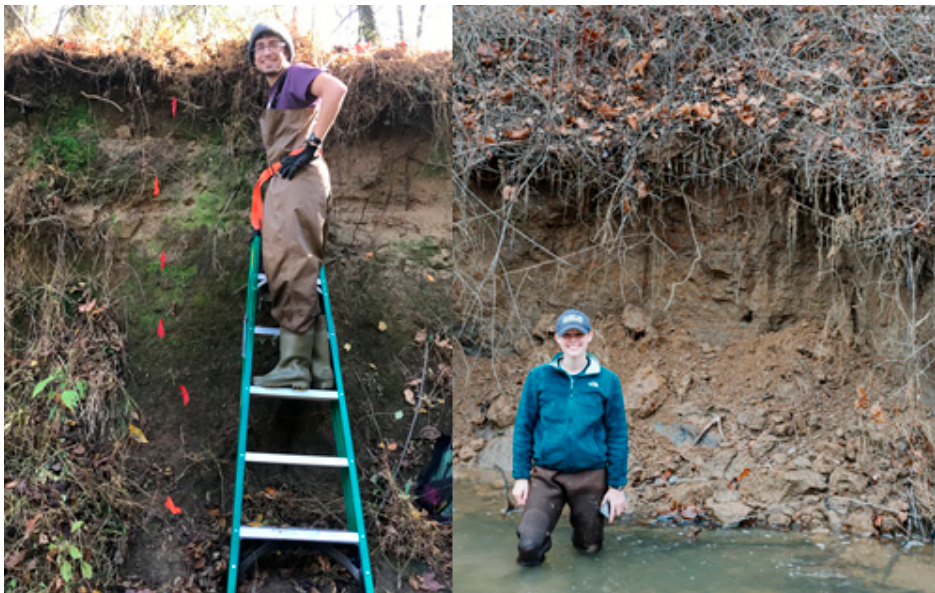
Figure 1. Examples of two streambank legacy sediment sites of the 15 sampled in this study which were upstream of now breached mill dams. Left: Nate Sienkiewicz at the streambank at Nature Center Beach (NCB; bank height 2.59 m). Red flags indicate locations for bank sampling. Right: Alyssa Lutgen in front of the eroding/slumping streambank at Scotts Mill Dam (SM2; bank height 2.74 m).